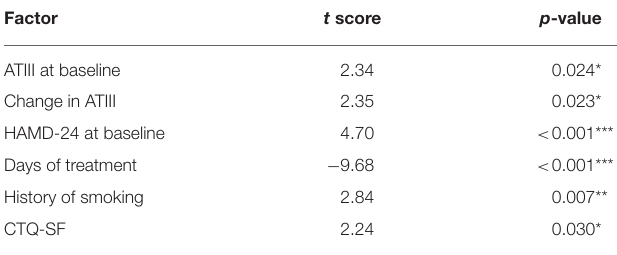
TABLE 2 | Potential predictive factors of HAMD-24 in the follow-up